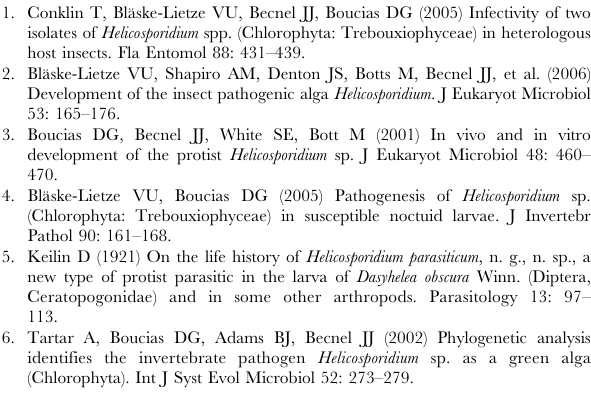
Figure S1 Predicted secondary structures of Helicosporidium rnl group I introns. The rnl group I introns displayed according to Burke et al were classified according to Michel and Westhof. Splice sites between exon and intron residues are denoted by arrows. Canonical Watson-Crick base pairings are denoted by dashes whereas guanine-uracyl pairings are marked by dots. Numbers inside variable loops indicate the sizes of these loops. The putative LAGLIDADG endonuclease encoded within the Hsp. rnl .1 intro- nic ORF contains a single copy of this motif. Figure S2 Trans -spliced GI introns insertion sites. The insertion sites of the Helicosporidium , Isoetes and Trichoplax trans -spliced group I introns are indicated by arrows on the Cox1 amino acid alignment (positions 225 to 464 shown). Numbers on the right of the alignment indicate the amino acid positions on the corresponding sequences. The different trans-spliced introns are indicated by roman numerals: I, Helicosporidium (Hsp. cox1 .2); II, Trichoplax ( cox1 intron 4); III, Trichoplax ( cox1 intron 5); IV, Isoetes (coxi1305). The Trichoplax intron insertion sites were taken from Burger et al . Figure S3 Densities of repeated elements in Helicosporidium and other chlorophyte mitochondrial genomes. Repeated elements identified with REPuter are connected by lines on the corre- sponding mtDNA circular representations (adapted from Kurtz). Repeats of at least 15, 30 and 45 nt are shown on the left, middle and right panels respectively. For this analysis, one copy of the Ostreococcus mtDNA inverted repeats has been removed. Also, the linear C. reinhardtii mitochondrial genome is represented here as a circle.